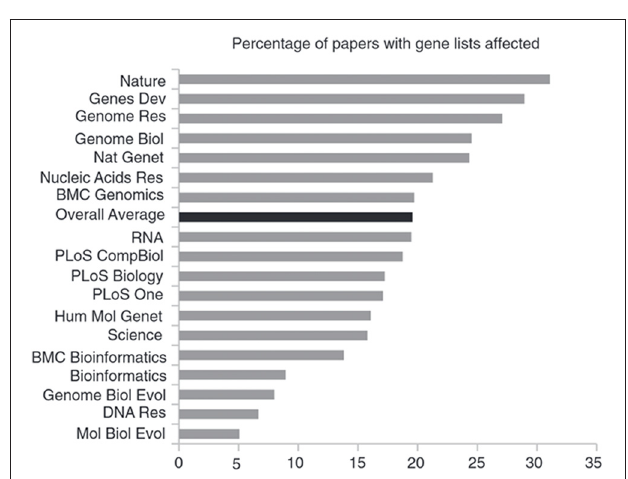
FIGURE 5 | Journals with above-average error-rate rank higher than journals with a lower error-rate. Shown is the prevalence of gene name errors in supplementary Excel files as the percentage of publications with supplementary gene lists in Excel files affected by gene name errors. Figure modified from Ziemann et al.